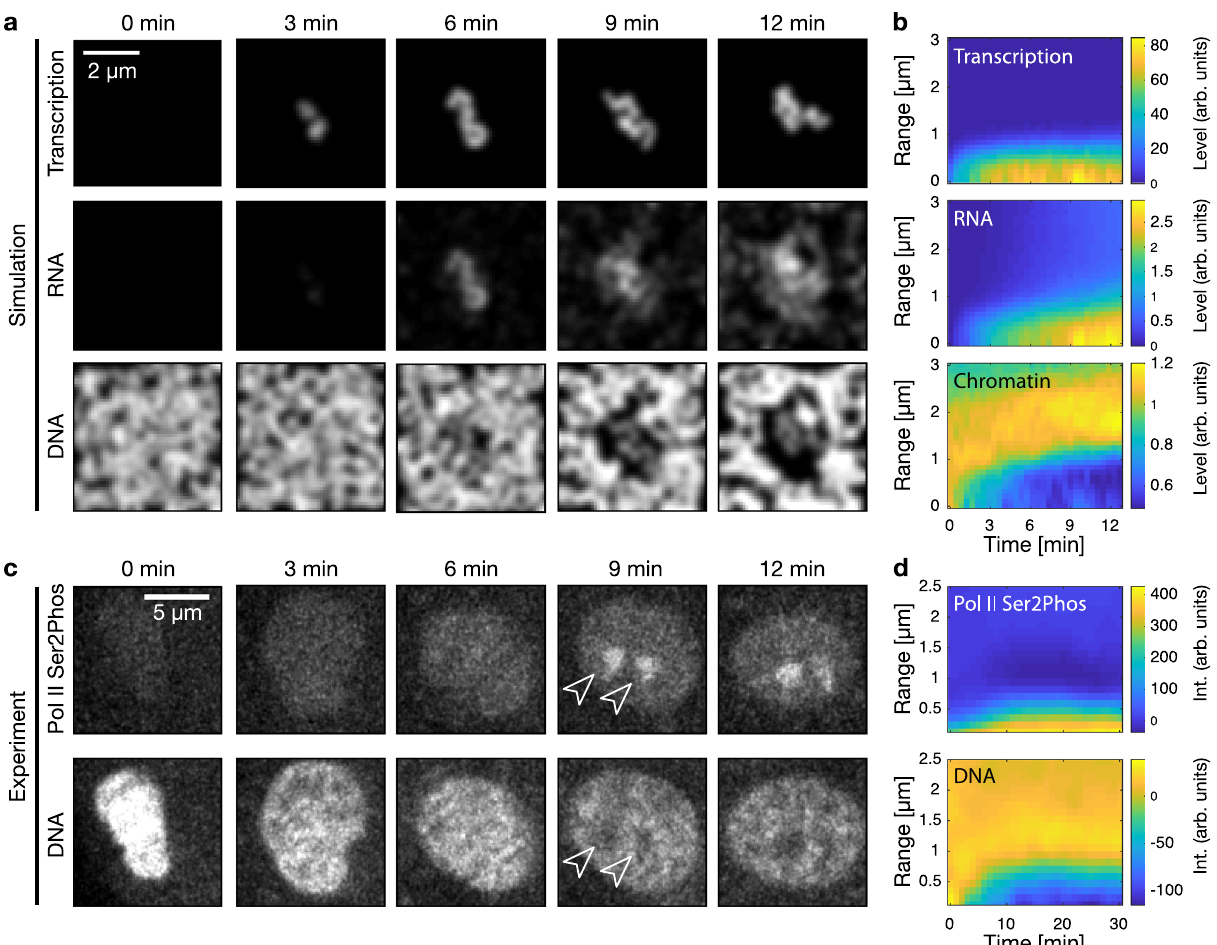
Fig. 4 Transcription onset locally reorganizes euchromatin. a Representative simulated time-lapse of transcription onset (Transcription), RNA accumulation (RNA), and euchromatin organization (DNA) in the vicinity of a single transcriptionally activated chromatin chain. The same results were obtained in 12 simulations. b Radial analysis, starting at the time when transcription foci were fi rst detected. The range indicates the radial distance from the centroid of a given transcription focus. Analysis averaged over 12 simulations. c Representative spinning disk confocal microscopy time lapse of elongating RNA polymerase II (Pol II Ser2Phos, visualized with phospho-speci fi c antibody fragments) and DNA (SiR-DNA). Images show nuclear mid- sections of a single nucleus taken from zebra fi sh embryonic cell culture corresponding to the late blastula (sphere) stage. The same results were obtained in three independent experiments. d Radial analysis averaged over time-lapse recordings from 13